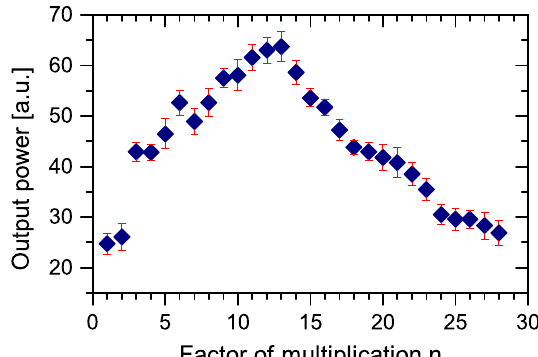
Figure 15. Dependence of OPO output power behind M10 on multiplication factor in the ring OPO.